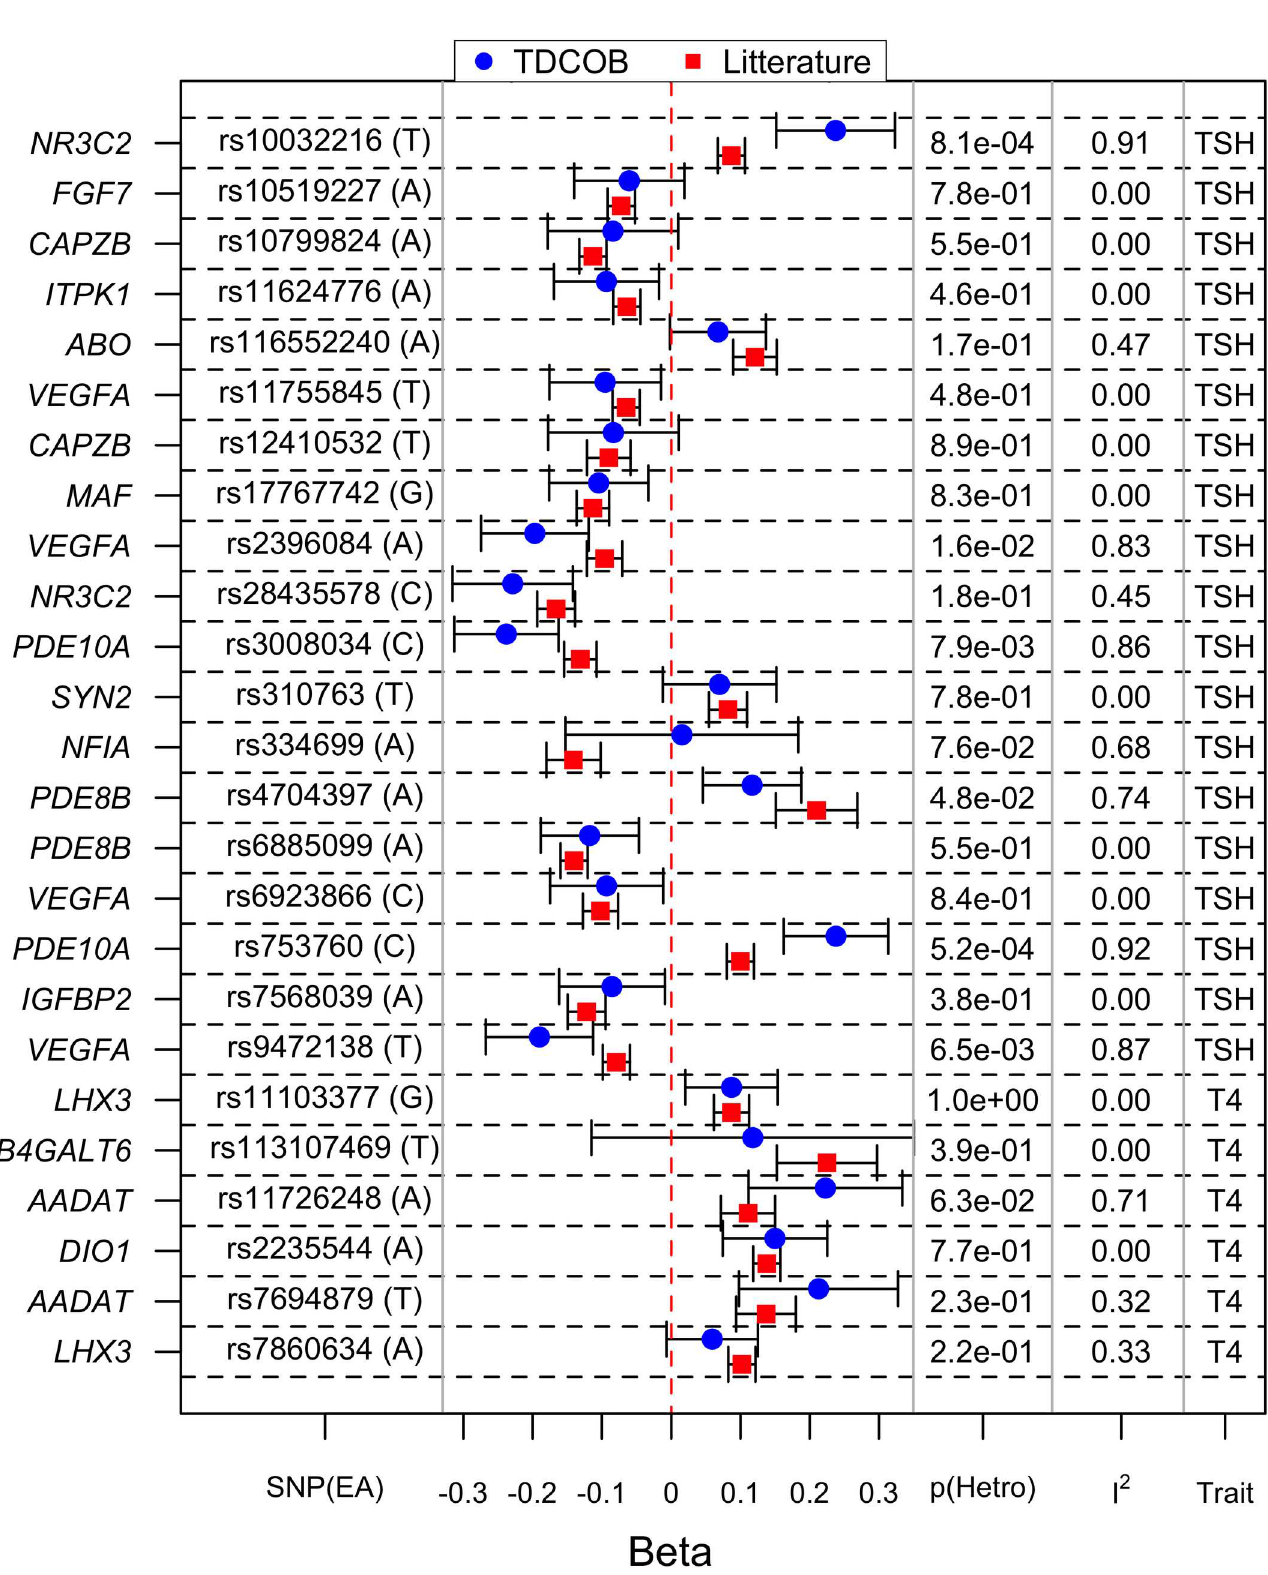
PLOS ONE | https://doi.org/10.1371/journal.pone.0174204 March 23,